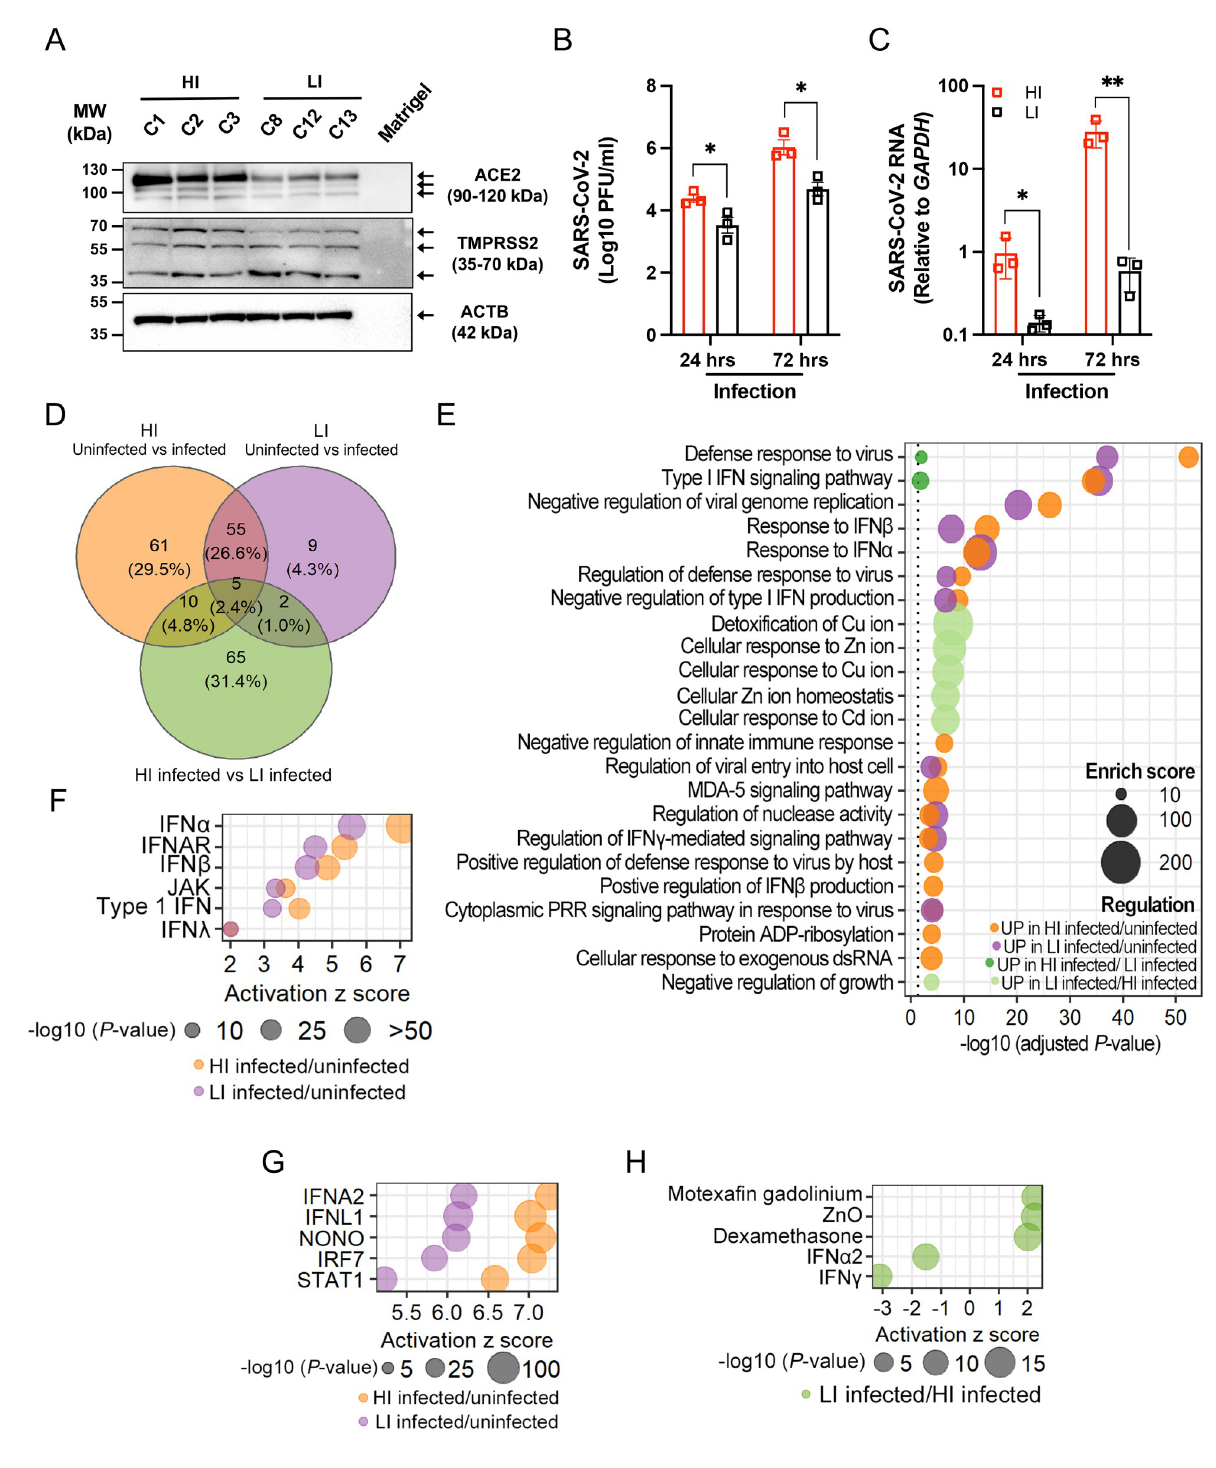
Fig 4. Transcriptome analysis reveals a heighted and delayed interferon response to SARS-CoV-2 infection in susceptible organoid-derived monolayers. (A) Western blot analysis of ACE2, TMPRSS2, and ACTB in high infection (HI; C1, C2, and C3) and low infection (LI; C8, C12, and C13) lines. Blots are representative of at least 3 independent repeats. (B) PFU determined by virus titration on Vero E6 cells of supernatant of HI and LI monolayers at 24 and 72 hours after infection with SARS-CoV-2. (C) RT-PCR analysis of SARS-CoV-2 expression in HI and LI monolayers upon 24 and 72 hours infection with SARS-CoV-2. (D) Venn diagram depicting the number and overlap of DEGs according to RNA-seq analysis (see S7 Fig) of